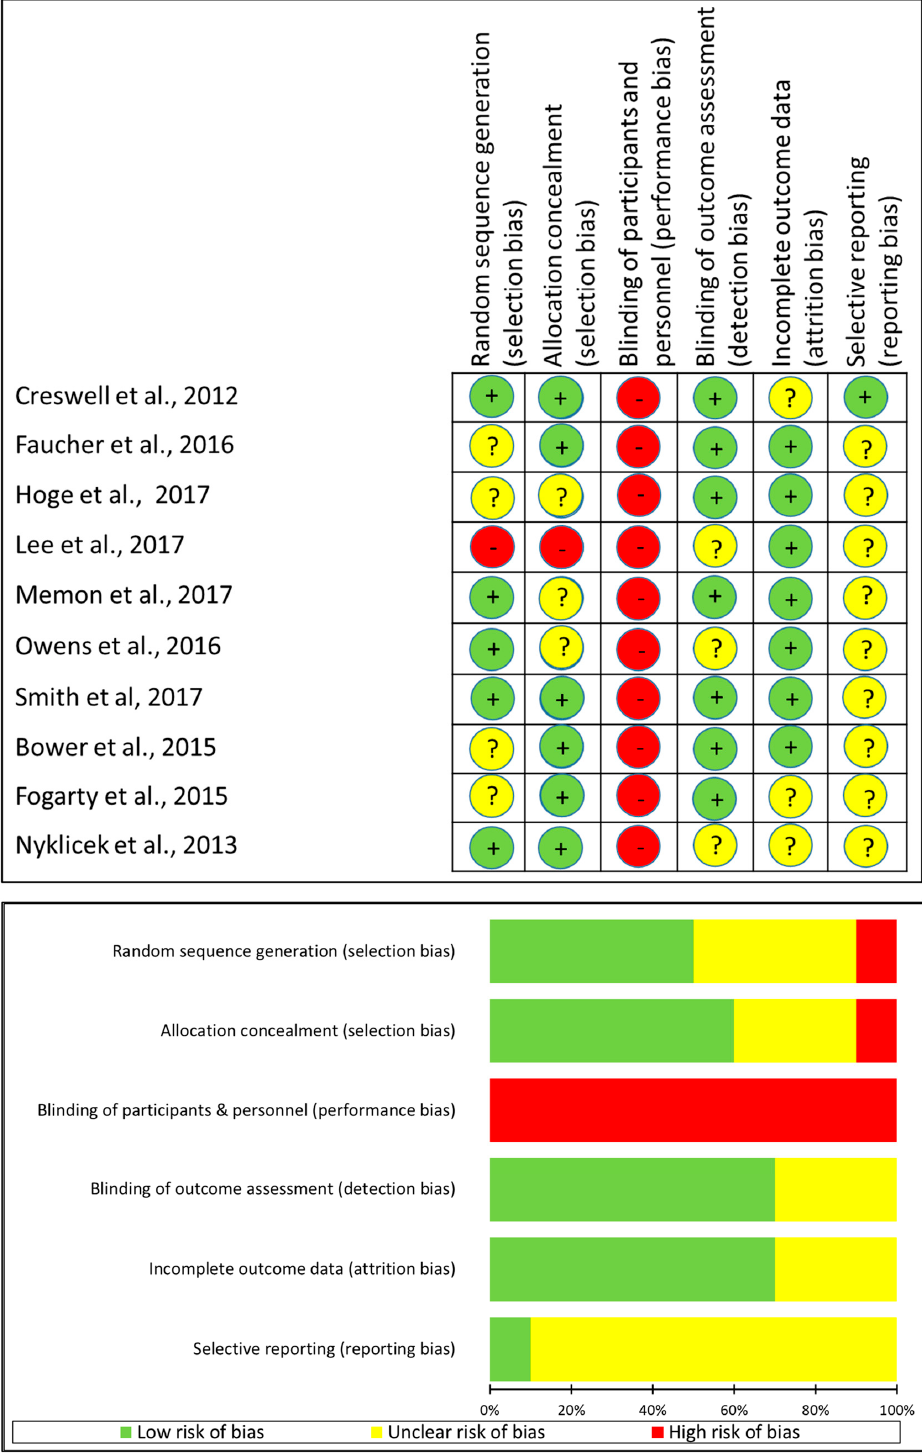
Figure 2: Risk of bias of included studies. Figure 2. Risk of bias of included